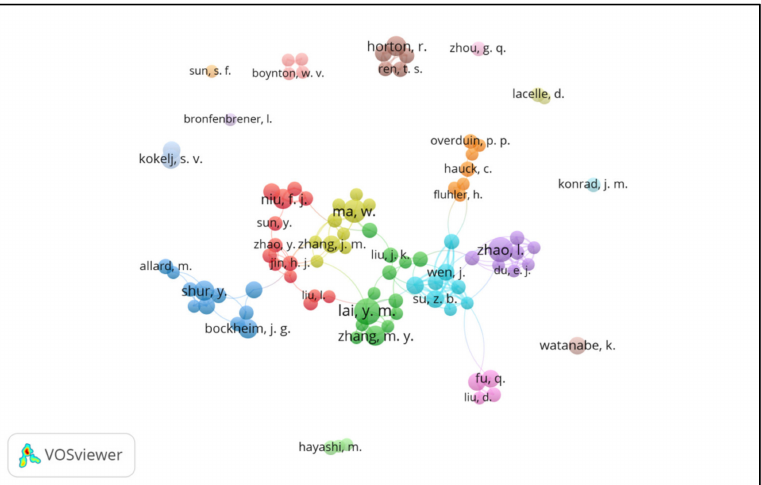
Figure 2. The co-authorship network visualization map of 95 authors out of 2023 authors with more than five publications as produced by VOSviewer. The size of circle and font in the map depends on the degree of nodes, the strength of links, and the amount of citations. The color of a circle represents the cluster to which it belongs and different clusters are represented by different colors. Table 1. Top 10 authors, organizations, and countries published publications of unfrozen water in the frozen soil (UWFS). HistCite Pro is used to analyze and count the number of publications (N), total local citation score (TLCS), and total global citation score (TGCS). VOSviewer is used to count indices of links (L), total link strength (TLS), and citations (C). The TGCS in HistCite Pro is the same as C in VOSviewer and they are, therefore, merged.